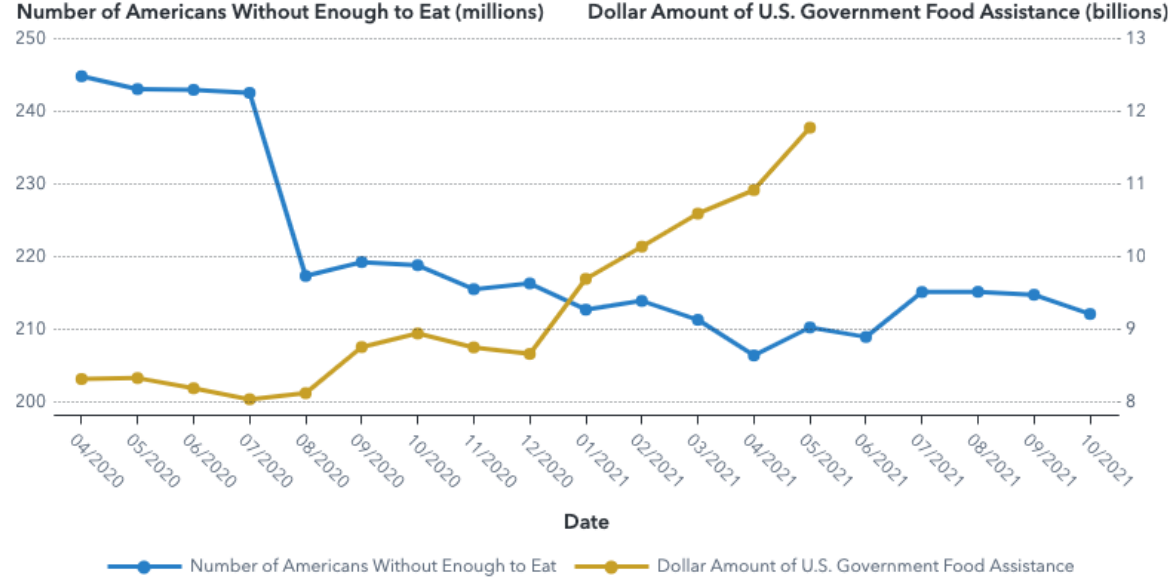
Figure 4. Comparison of the number of food insufficient Household Pulse Survey respondents [25] and the dollar amount of food assistance cash payments (SNAP [28], school lunch, school breakfast, and child and adult care food [29]), April 2020–October 2021. All data used in this graph is publicly available government data.